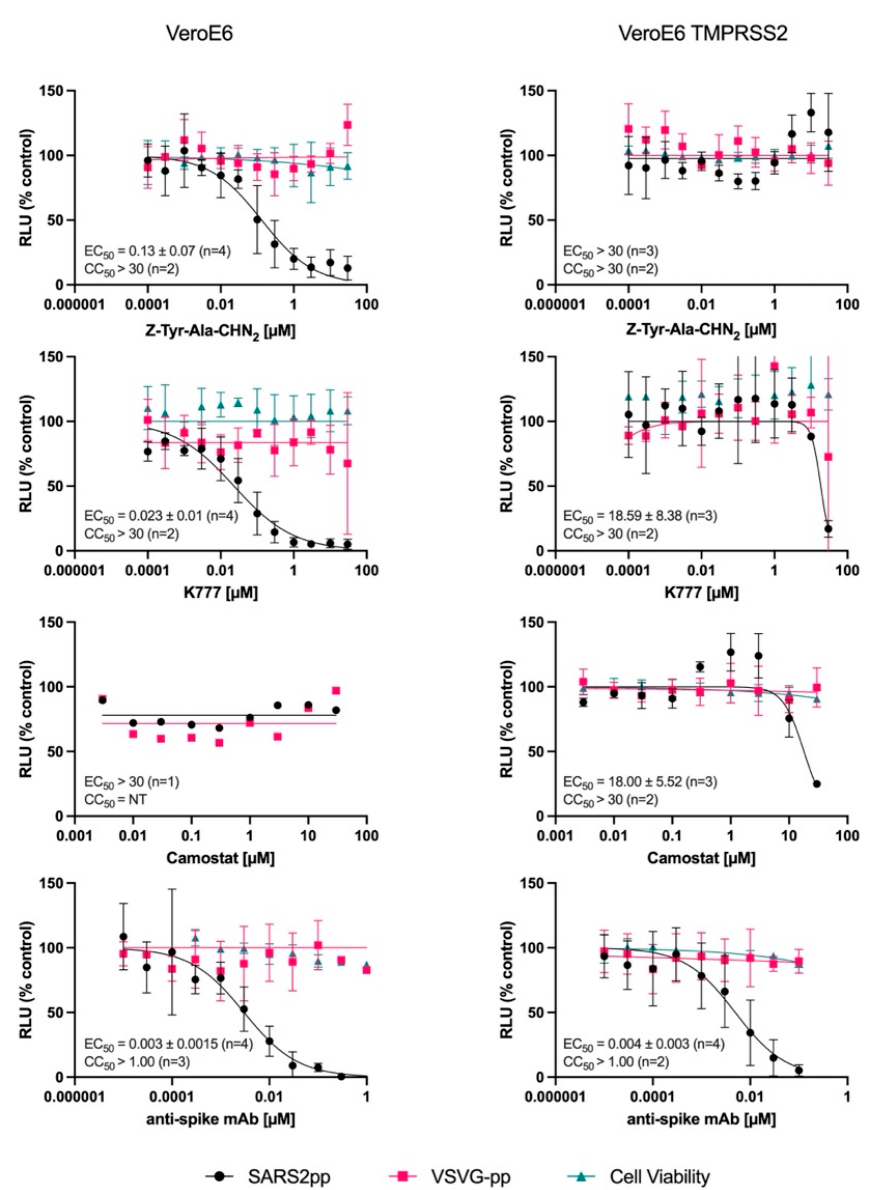
Figure 6. Pseudotyped SARS-CoV-2 neutralization assay in VeroE6 cells (left panel) and in VeroE6 TMPRSS2 cells (right panel). The Regeneron monoclonal antibody was included as a positive control because it can block entry in both cell types. VSV-Gpp was included to determine the specificity of the compounds. For infection with SARS2pp and VSV-Gpp, the mean ± SD values are shown for three to four independent experiments, whereas for cell viability, the mean ± SD values are shown for two to three independent experiments. Mean EC 50 and CC 50 values of the different compounds in the pseudotyped SARS-CoV-2 neutralization assay are given as well. NT, not tested; TMPRSS2, transmembrane protease serine subtype 2; VSV-Gpp, vesicular stomatitis virus fusion glycoprotein G; SARS2pp, SARS-CoV-2 S protein.